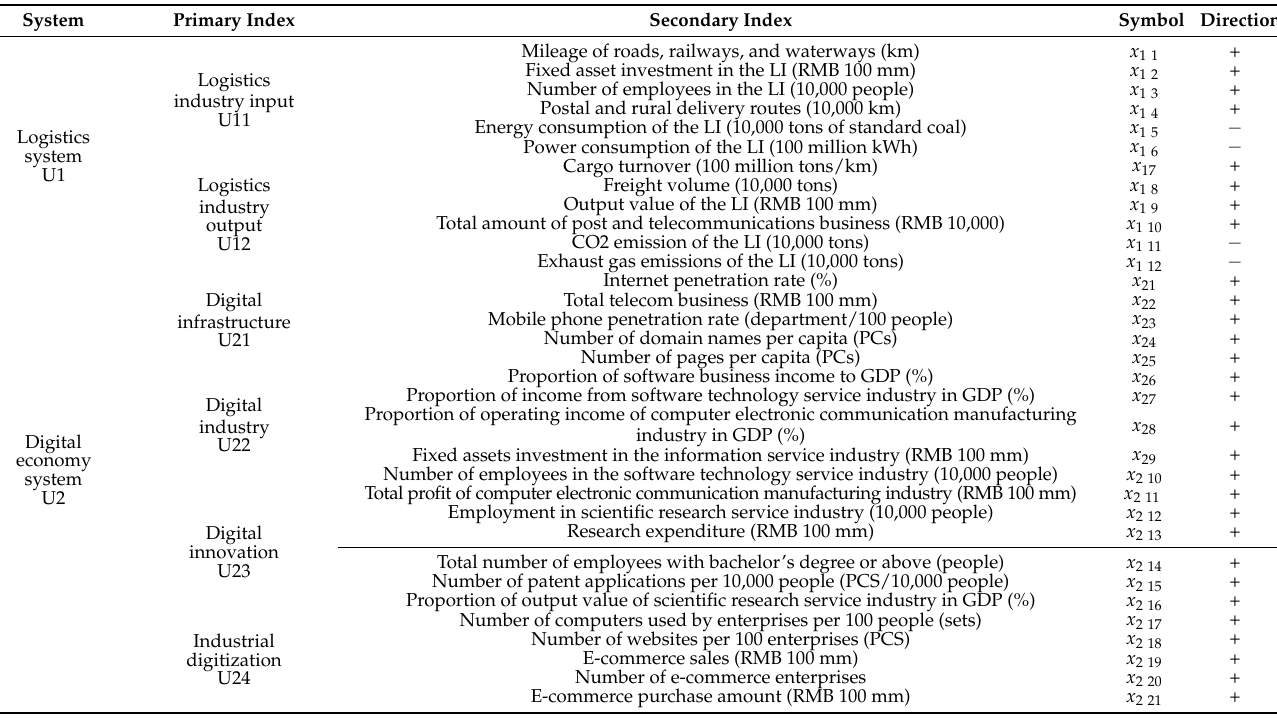
Table 1. Index system of the CCD of the LI and DE